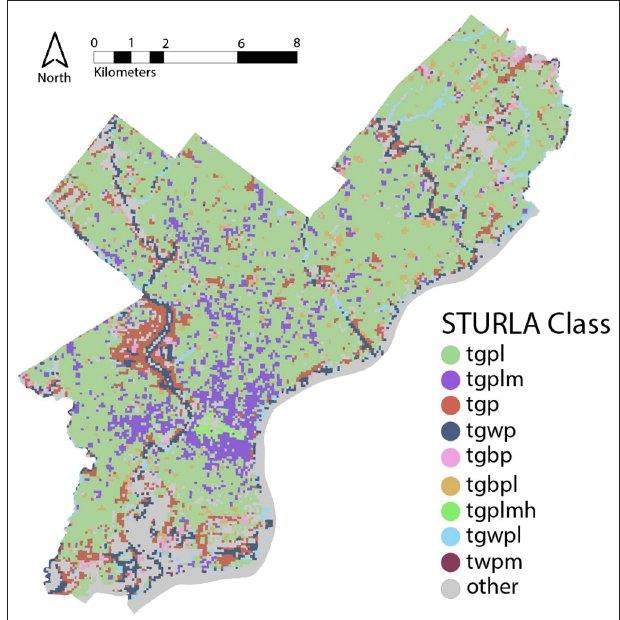
FIGURE 1 | STURLA map of Philadelphia, Pennsylvania, USA where each color corresponds to a different STURLA code. T, trees; G, grass; B, bare; W, water; P, pavement; L, low-rise; M, midrise; H, highrise. The combination of these individual letters creates a STURLA code; for example, class tgpl is composed of various proportions of trees (T), grass (G), pavement (P), and low-rise buildings (L).